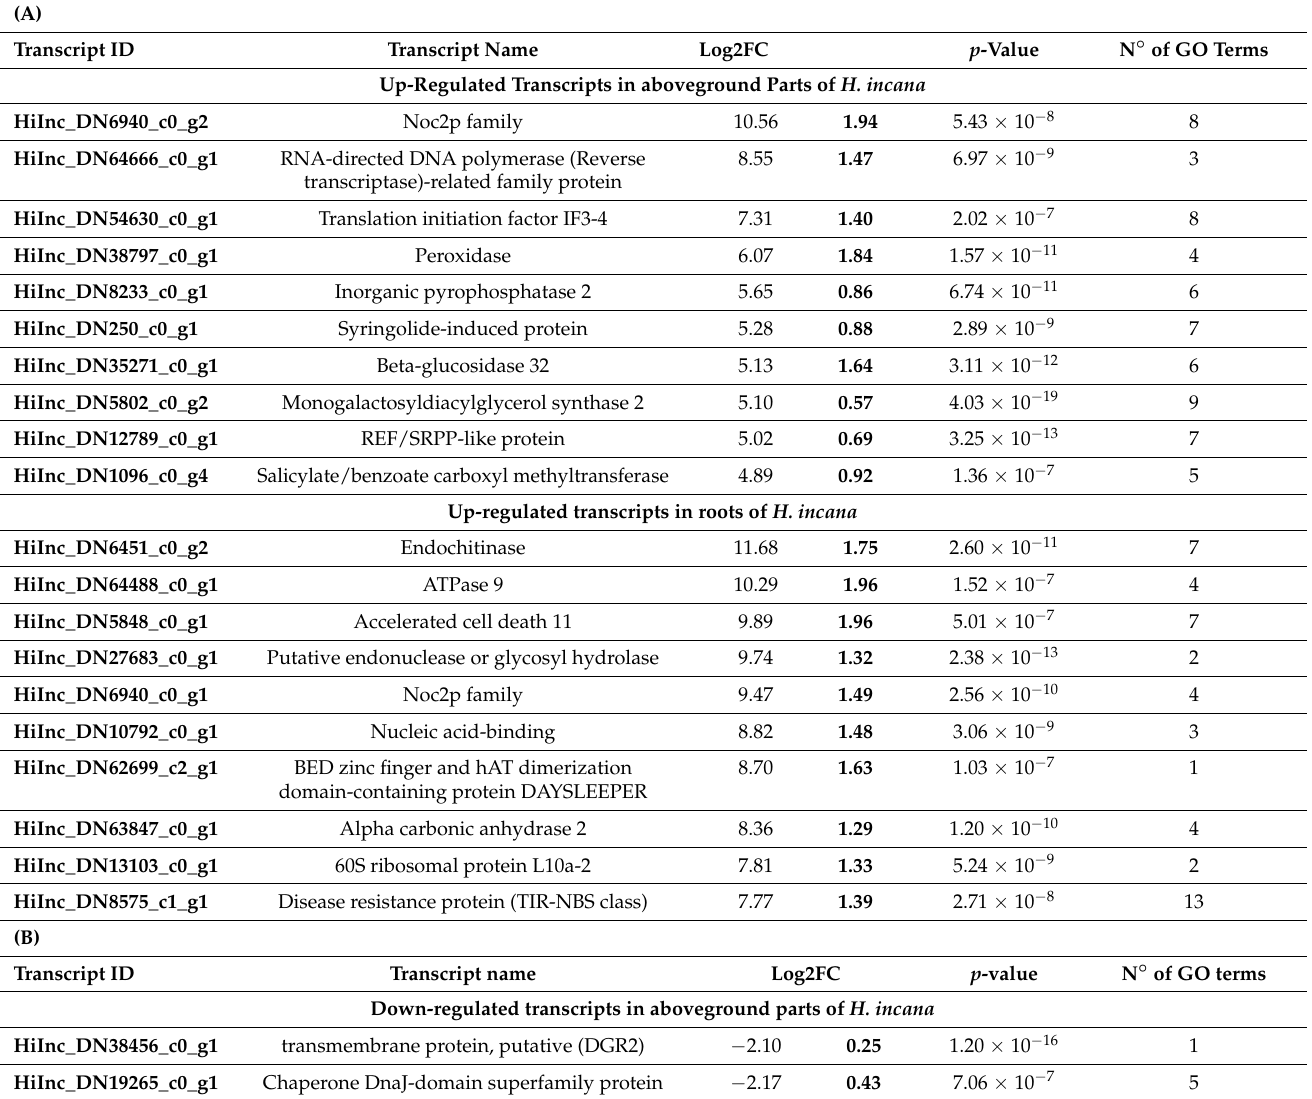
(Table S5). The ATP-Mg/Pi transporter ( APC3 : mitochondrial substrate carrier family pro- tein) was shown upregulated in aboveground parts of H. incana during Pb stress (Table S5). AtAPC1 and AtAPC3 are known to transport phosphate compounds such as AMP, ADP, and ATP [44]. Abiotic stress, such as heavy-metal stress, causes increased energy demand [45], which requires high consumption of ATP and ADP [45]. The high energy consumption may be related to the expression of the APC3 gene under Pb stress. Table 2. Example of the most upregulated DEGs (A) and downregulated DEGs (B) in roots and aboveground parts of H. incana in response to Pb stress. Bold numbers indicate the standard error for the Log